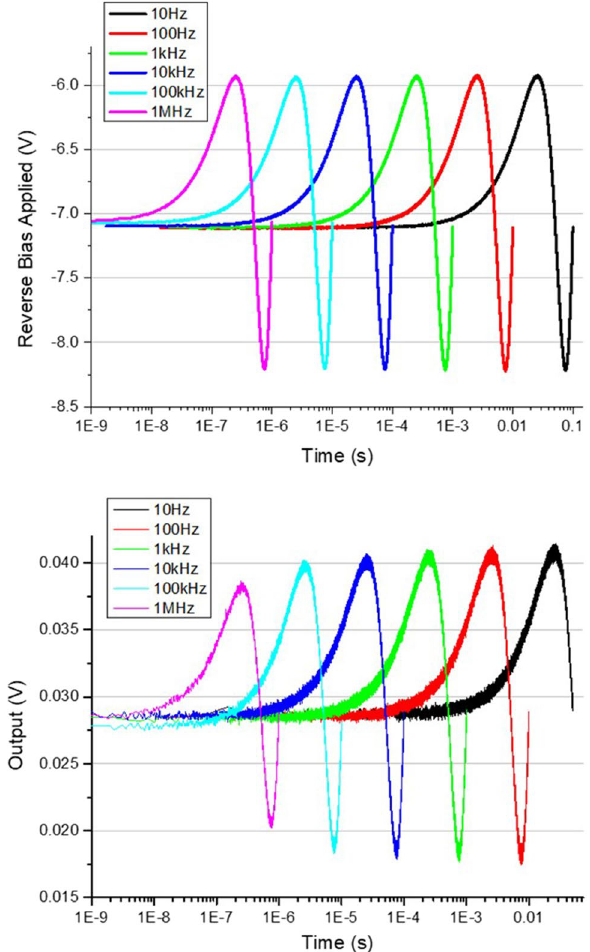
Figure 4. Above, the reverse bias signal applied to the absorber section of the MLLD across several modulation frequencies. Below, the detector output across the same modulation